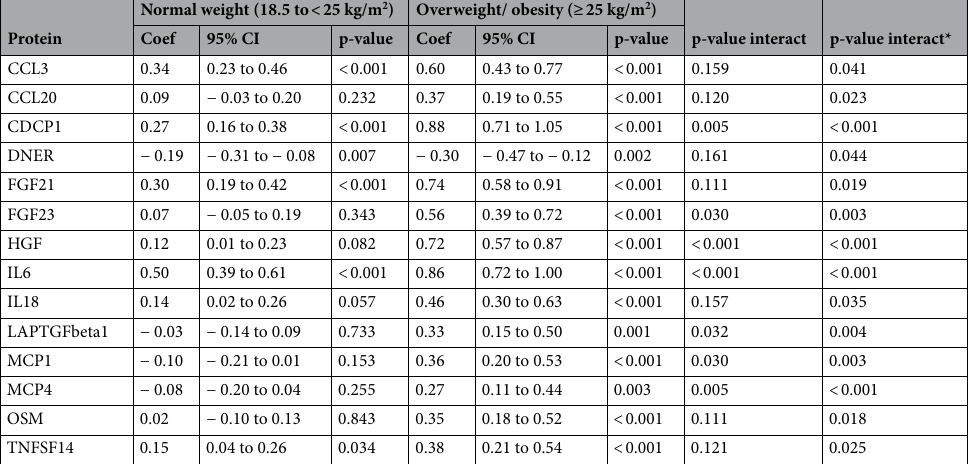
Table 3. Association between %BF and protein levels stratified by BMI categories. Stratified analyses in BMI categories from linear regression of transformed protein levels adjusted for sex, smoking, e-cigarette use, snuff use, and age at follow-up. The table includes all proteins with unadjusted p-value for the interaction term %BF#BMI_category of < 0.05. p-values at 0.05 FDR. *p-value for the interaction term without FDR correction.